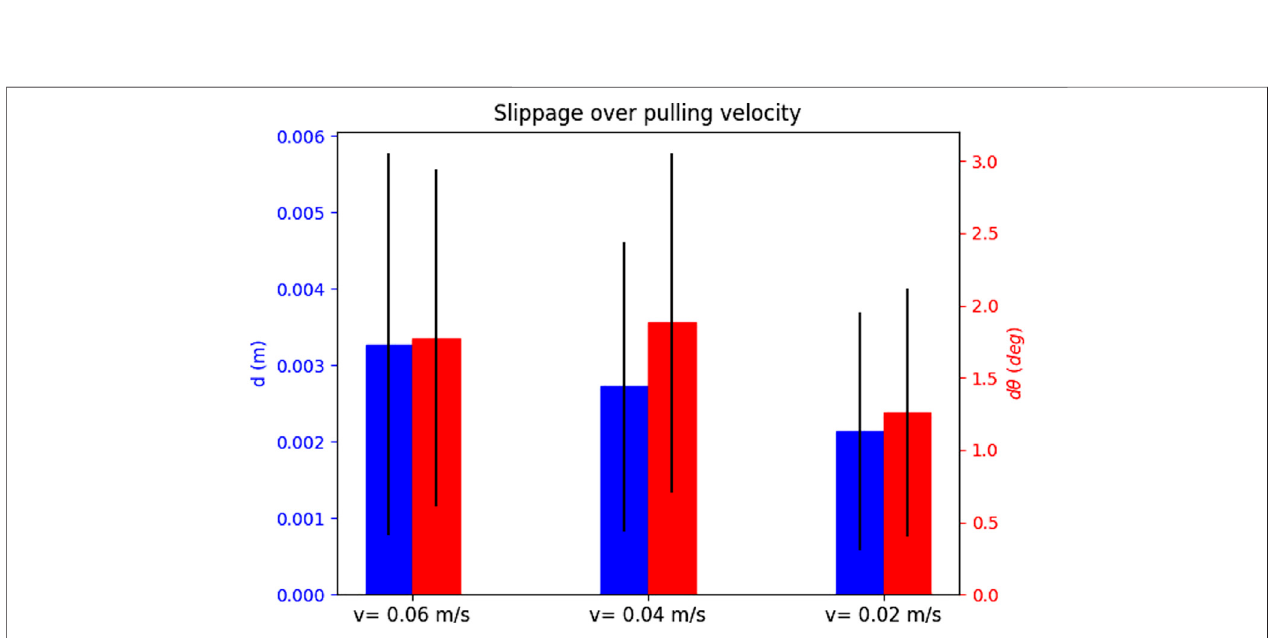
FIGURE 8 | The effect of the physics engine on grasp stability for the simulation experiment. The blue bars show the mean and standard deviation of the translational slippage, and the red bars those of the rotational slippage.